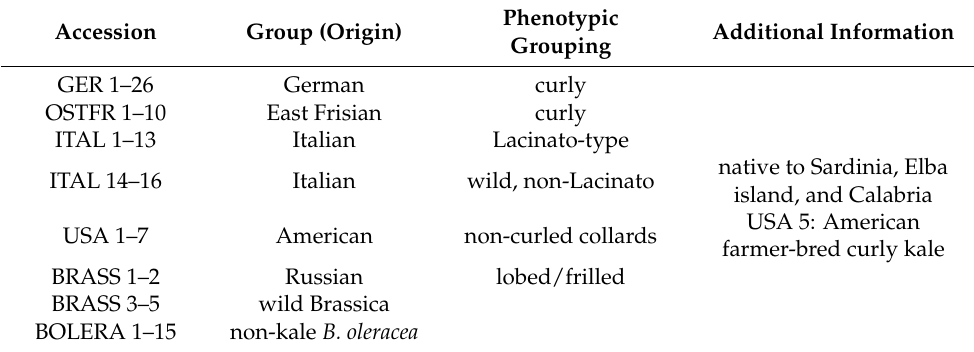
Table 1. Information on kale and cabbage varieties included in this study. For detailed information on accessions and variety names refer to Supplementary Table S1. We generally followed the classification by Gladis and Hammer